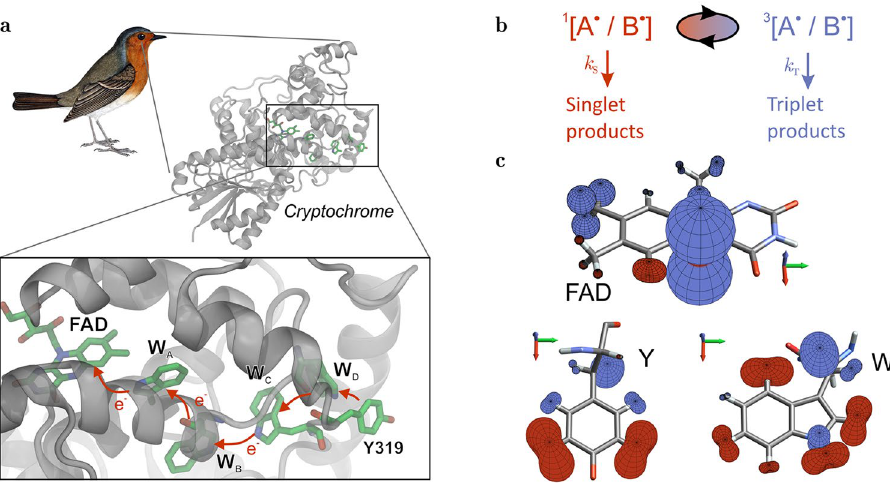
Figure 1. ( a ) Structure of an avian cryptochrome (PDB identifier: 6PU0, Columba livia ), including the central electron transfer chain comprising four tryptophans (W) labelled A (W395), B (W372), C (W318) and D (W369) and ending in the surface exposed tyrosine Y319. Photo-excitation of FAD in cryptochrome initiates consecutive electron transfer reactions of adjacent donors/acceptor pairs (red arrows), producing sequential radical pairs of the form [ FAD ·− / W ·+ ] and possibly [ FAD ·− / Y · ] (see e.g. ref. 21). The well separated radical pairs involving W C and W D have been implicated with magnetoreception. Alternative radical pair models have been discussed, e.g., in the context of dark-state reoxidation 22–24 . ( b ) Generic radical-pair reaction scheme. The radical pair is born in the singlet state (spin multiplicity indicated by superscript labels, total electronic spin: S = 0 ) which, via coherent interconversion, can interconvert to a triplet state ( S = 1 ). Here, A · is assumed to be FAD and B · is a tryptophan (W) or tyrosine (Y) residue. The radical pair may form singlet and triplet products with rate constants k S and k T , respectively. The singlet channel typically comprises radical pair recombination and spin-independent protein structural rearrangements; the latter also contributes to the triplet channel. ( c ) Graphical representation of hyperfine interactions in FAD ·− (top), Y · (bottom left) and W ·+ (bottom right). Here, in the direction given by the unit vector d , the plotted surfaces are drawn at distance || Ad || from the location of the nucleus in question, whereby 1 Å corresponds to 17 MHz. Surfaces are coloured according to the sign of the projection, with blue and red corresponding to positive and negative signs, respectively. The molecules are shown in their respective standard